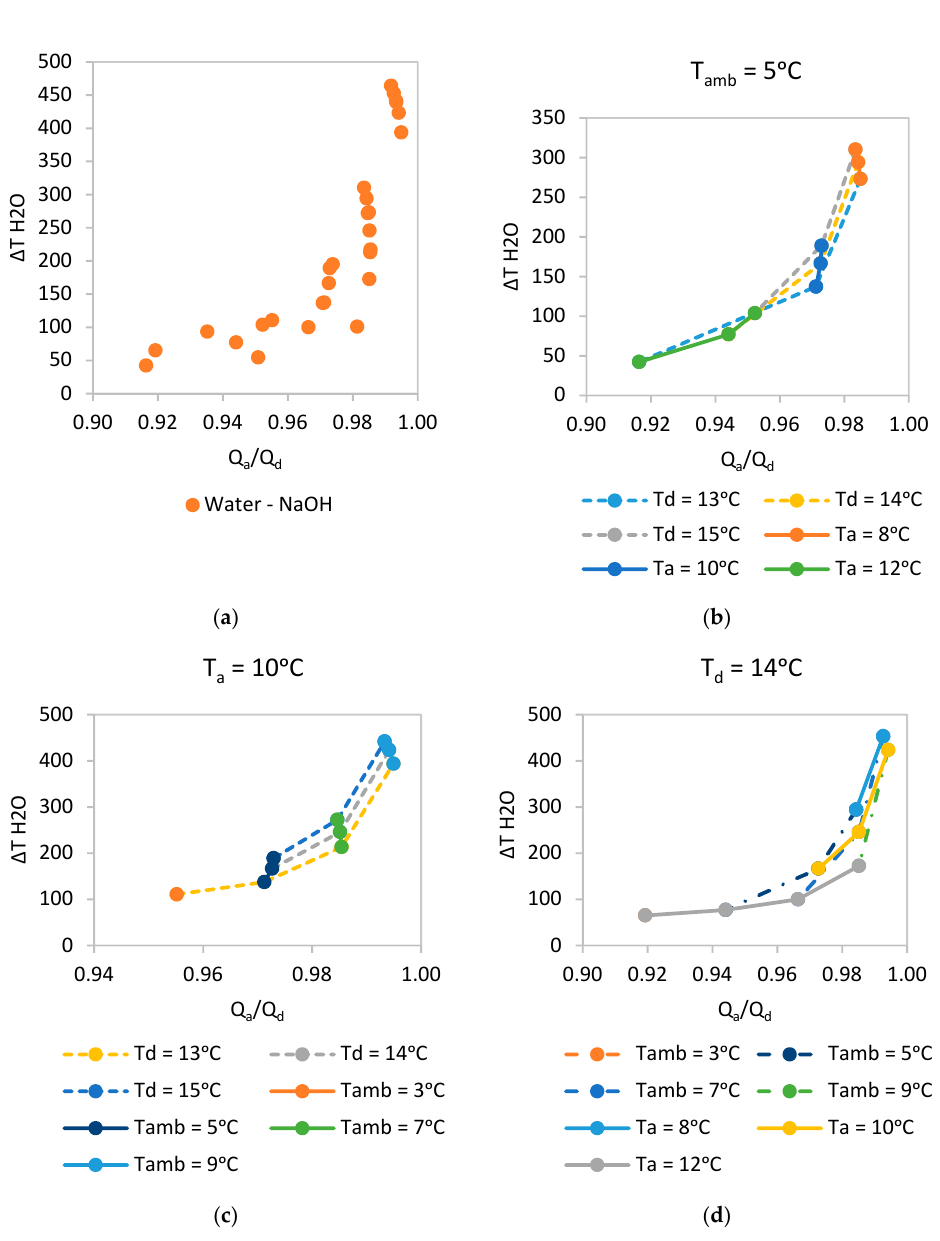
Figure 6. ( a ) Water–NaOH pair performance data points for T amb = 3, 5, 7, 9 ◦ C , T a = 8, 10, 12 ◦ C and T d = 13, 14, 15 ◦ C, ( b ) Data points for T amb = 5 ◦ C linked by T a and T d . ( c ) Water-NaOH pair performance data points for T d = 14 ◦ C linked by T amb and T a , ( d ) Data points for T a = 10 ◦ C linked by T amb and T d .